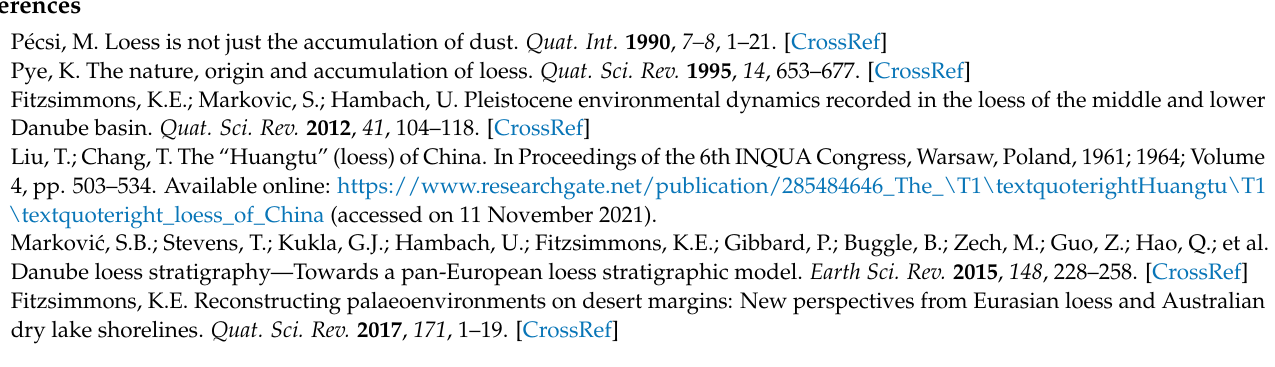
Table S1: Overview of luminescence samples collected from the profile RP1, Table S2: Summary of equivalent dose values for the different mineral and grain-size fractions measured for profile RP1 [53], Table S3: Overview of samples from core REM3B measured for this study with respect to measurement protocol, mineral and grain-size fraction, Table S4: Dose recovery and residual dose results for selected samples from core REM3B measured using the pIR 200 IR 290 protocol, Table S5: Summary of depths and averaged De values and test dose sensitivity values for the ten fine- grained (4–11 µ m) and five very fine sand (63–90 µ m) quartz OSL samples measured in this study, Table S6: Summary of depths, number of aliquots measured, measurement protocol and averaged uncorrected De values for the 18 very fine sand (63–90 µ m) K-feldspar samples measured in this study using pIR-IR protocols, Table S7: Summary of depths, averaged De values and test dose sensitivity values for the bulk IRSL 50 measurements from the REM3B core, Table S8: Summary of depths, average and standard deviation of test dose sensitivity values for the different mineral and grain-size fractions measured for profile RP1, Table S9: Summary of depths, averaged De values and test dose sensitivity values for the ten fine-grained (4–11 µ m) quartz OSL samples measured in this study, Table S10: Summary of depths, averaged De values and test dose sensitivity values for the five very fine sand (63–90 µ m) quartz OSL samples measured in this study, Table S11: Summary of depths, averaged uncorrected De values and test dose sensitivity values for the 11 very fine sand (63–90 µ m) K-feldspar samples measured in this study using the pIR-IR protocols, Figure S9: IR 50 sensitivity vs. stratigraphy, as divided between soils and loess, Figure S10: IR 50 sensitivity vs. OIS [53], Figure S11: Log-transformed IR 50 sensitivity plotted against clay content [53], Figure S12: Log-transformed IR 50 sensitivity plotted against Si/Al ratios [88], Table S12: Settings and results of the statistical analyses testing the relationship of sensitivity with stratigraphy, OIS, depth, clay, and Si/Al